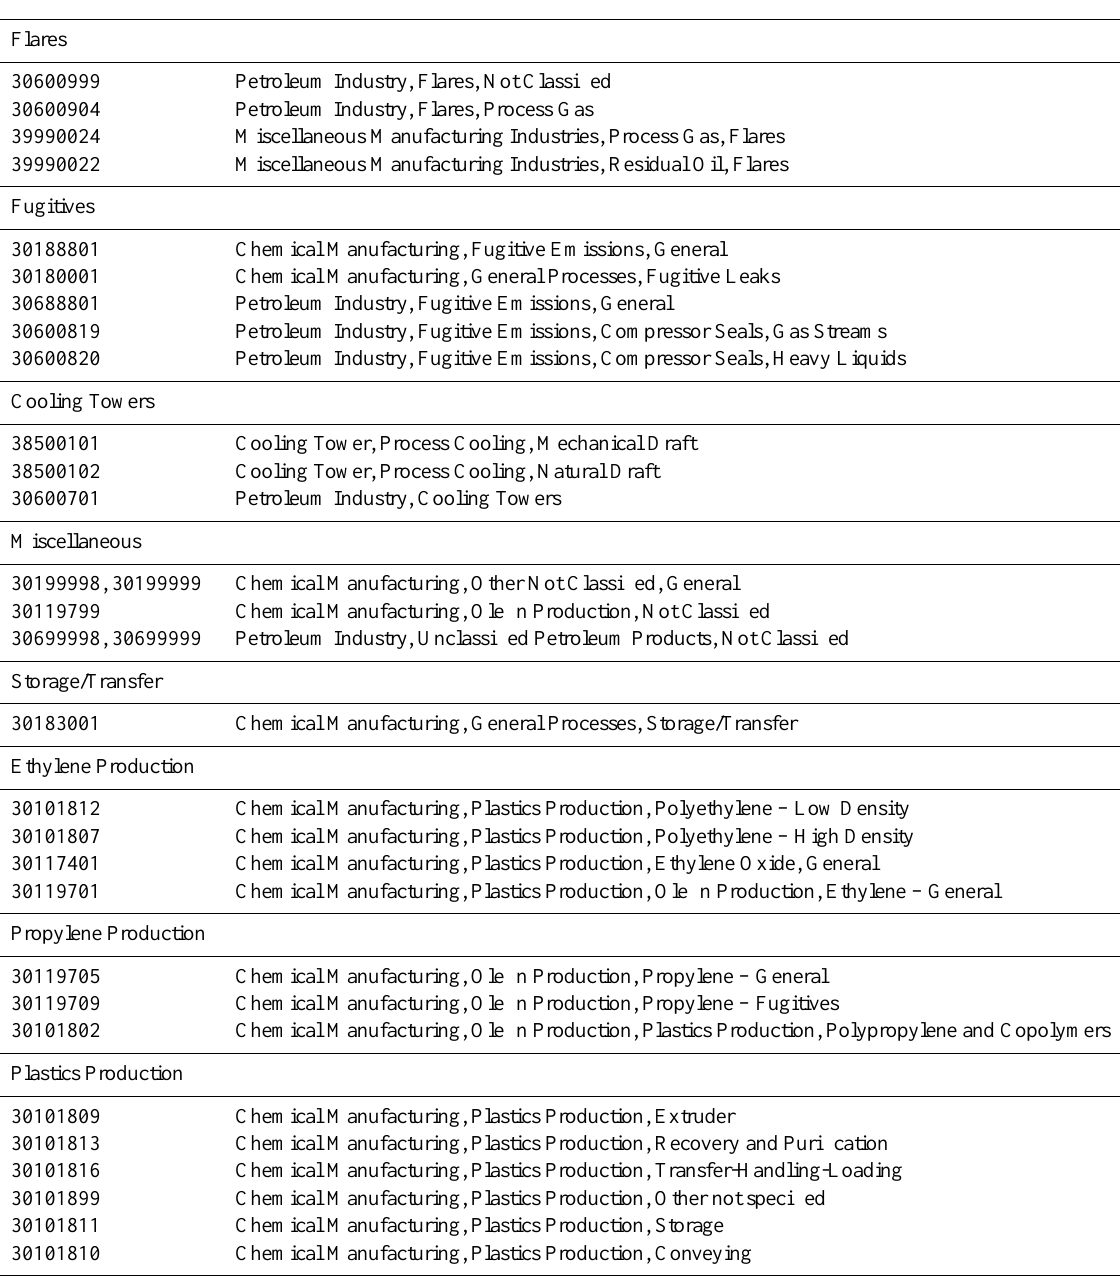
Table 8. Eight emission categories used in ethylene and propylene NEI-2005 emission perturbations, their 8-digit US EPA Source Classifi- cation Codes, and brief descriptions of